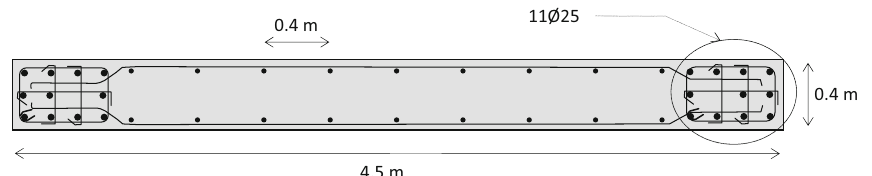
Fig. 5 Cross-section of one wall